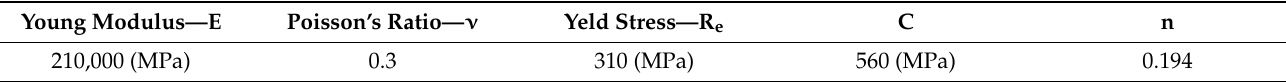
Table 1. Material model data for numerical analysis.